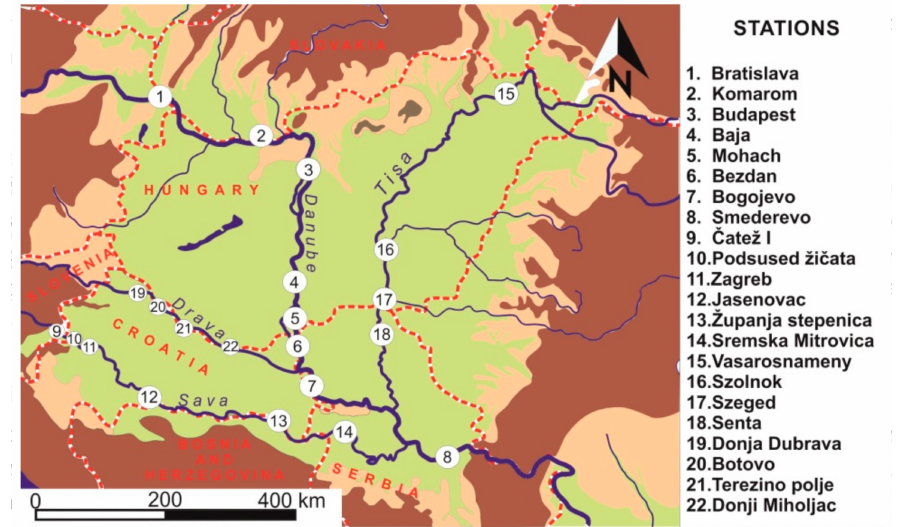
Figure 1. Geographical location of the stations within the Pannonian